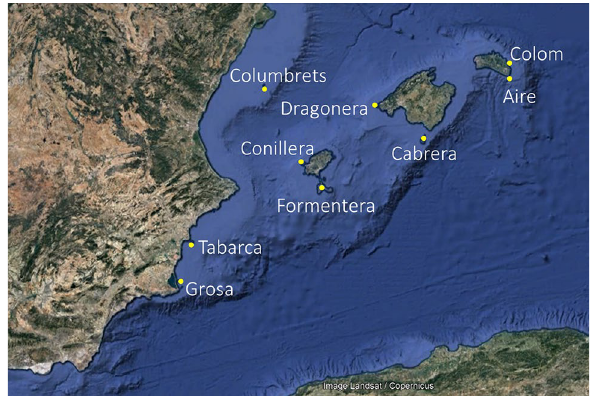
Figure 2. Geographical location of studied islands in the western Mediterranean. Image source: Google Earth. Data SIO, NOAA, US Navy, NGA, GEBCO. Image